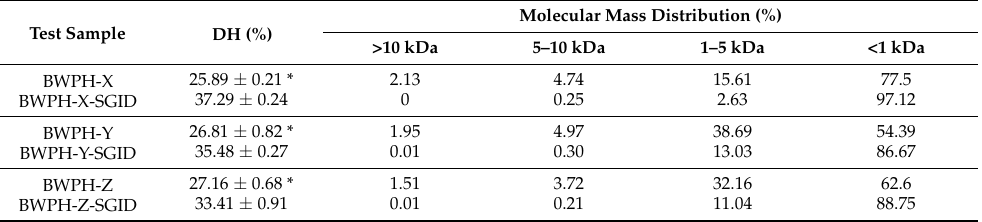
Table 1. The degree of hydrolysis (DH) and molecular mass distribution profiles of the blue whiting ( Micromesistius poutassou ) protein hydrolysates (BWPHs) pre- and post-simulated gastrointestinal digestion (SGID), Data reported as mean ± SD (n = 3). * Indicates a significant difference at p < 0.05 between pre- and post-simulated gastrointestinal digestion values.